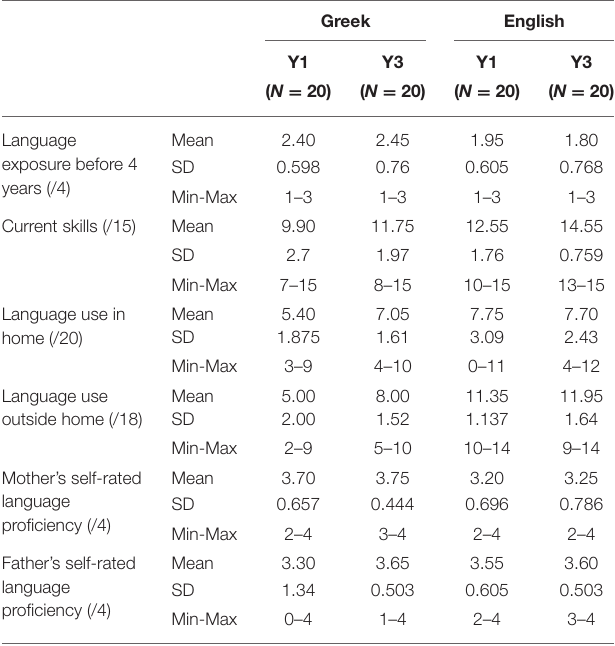
TABLE 1 | Descriptive statistics of language exposure before 4 years, current skills, language use in the home and outside the home, mother and father’s self-rated language proficiency in Greek and English.